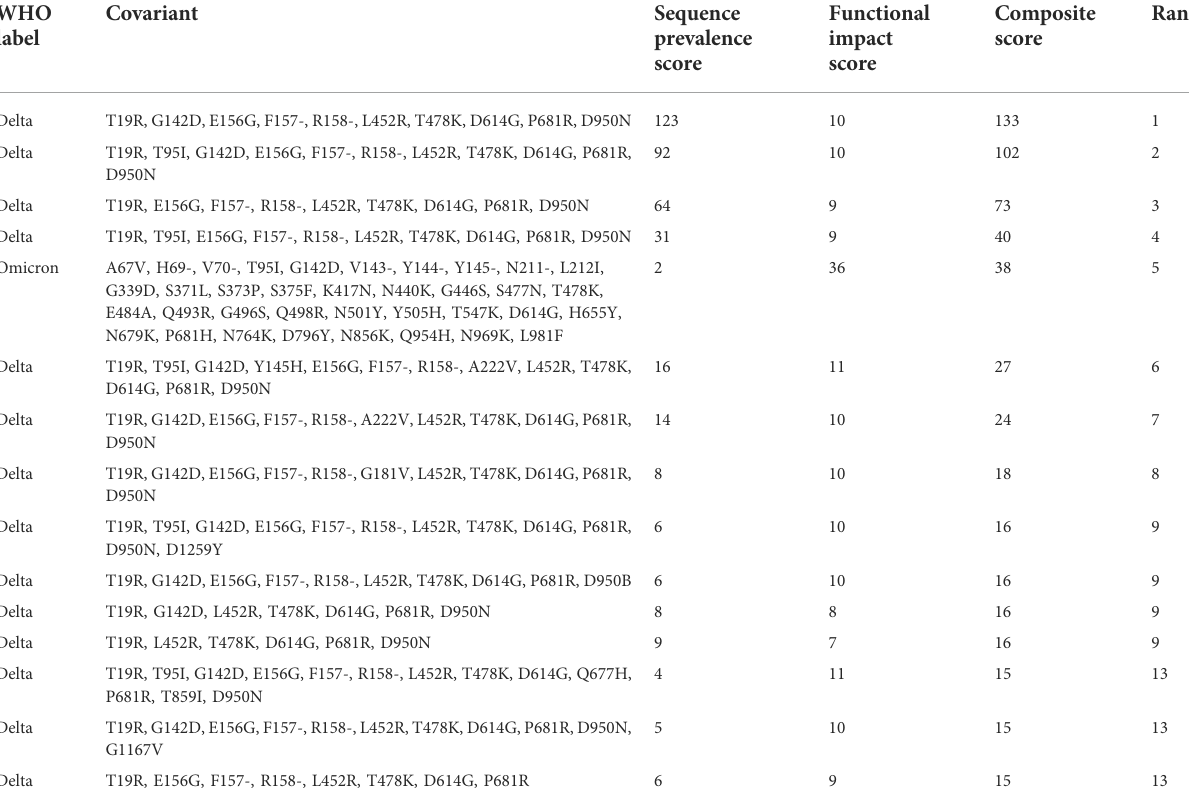
TABLE2GlobalSpikeCovariantRankingwiththeCompositeScore.TheoutputofarankingbasedonGISAIDdatauptoNovember2021.Theanalysis returnsaglobalrankingforallSpikevariantsbasedonthe CompositeScore .Inthiscase,theOmicronvariantjumpedconsiderablyinrankrelative to the ranking based on the Sequence Prevalence Score alone as shown in Table 1, thus showing the impact of quantifying the Functional Impact Score in overall variant